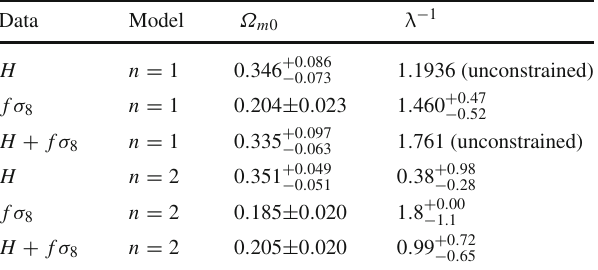
Fig. 3 MCMC simulations for the f ( R ) model with n = 1, consid- ering H ( z ) data and the flat priors: λ − 1 = [ 0 . 001 , 1 . 8 ] and Ω m 0 = [ 0 . 2 , 0 . 6 ] Table4 Resultsofourlikelihoodanalysesforthecosmologicalparam- eters and their uncertainties